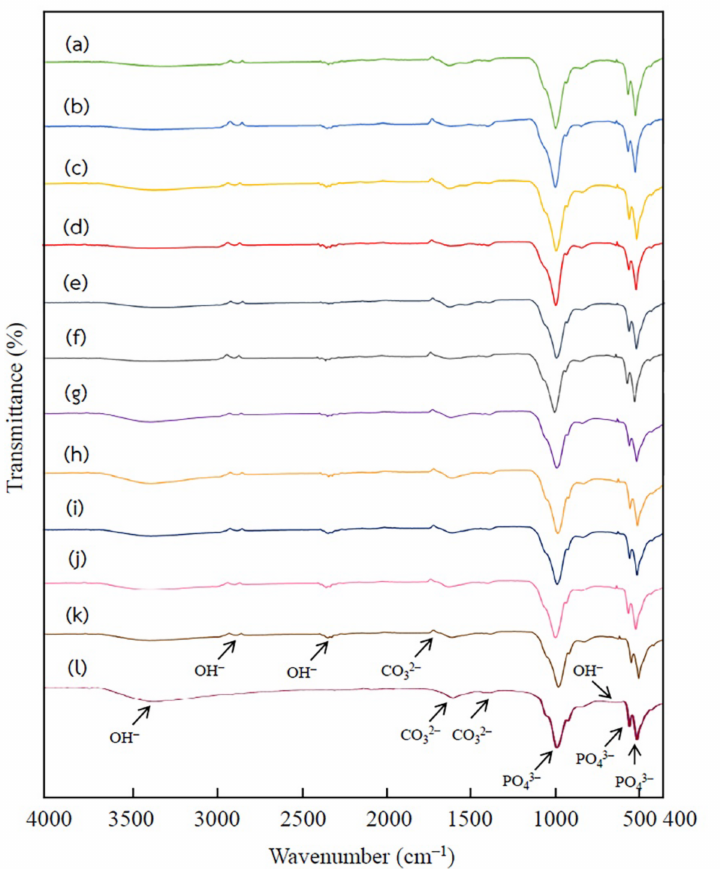
Figure 2. The FTIR spectra of hydroxyapatite extracted using 2% HCl 10 min ( a ), 5% HCl 10 min ( b ), 2% HCl 60 min ( c ), 5% HCl 60 min ( d ), 2% HCl 35 min ( e ), 5% HCl 35 min ( f ), 3.5% HCl 10 min ( g ), 3.5% HCl 60 min ( h ), 3.5% HCl 35 min Rep.1 ( i ), 3.5% HCl 35 min Rep.2 ( j ), 3.5% HCl 35 min Rep.3 ( k ), and the commercial hydroxyapatite ( l